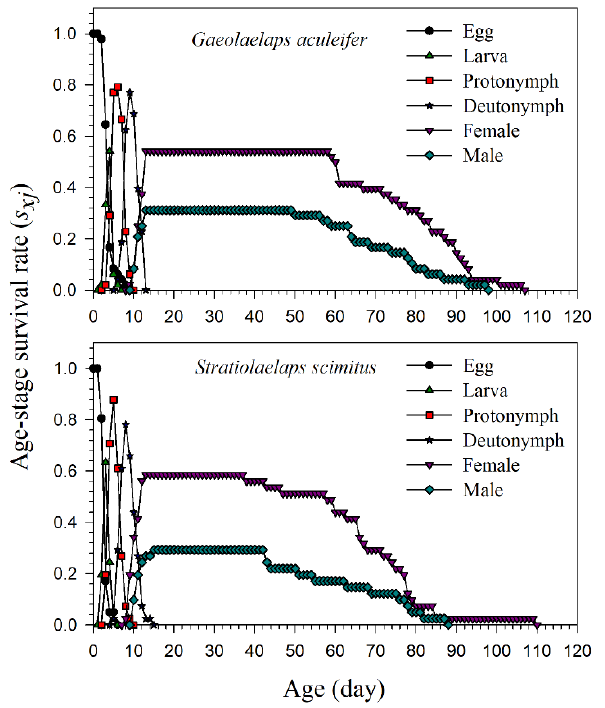
Figure 2. Age-stage-specific survival rate ( s xj ) of G. aculeifer and S. scimitus fed on T. putrescentiae . Figure 3 shows the age-specific survival rate ( l x ), female age-specific fecundity ( f x 5 ) (the female adult being in the fifth life stage), age-specific fecundity ( m x ), and age-specific maternity ( l x m x ) for G. aculeifer and S. scimitus fed on T. putrescentiae . The l x curve of G.